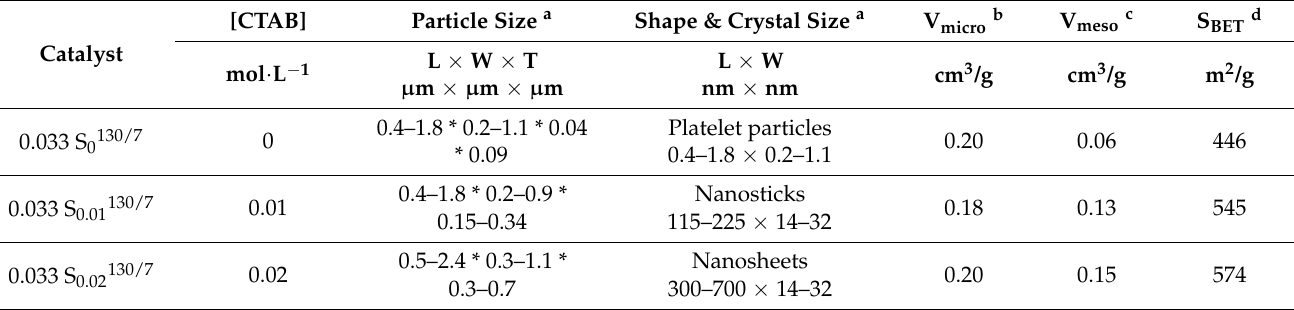
Table 1. Textural properties of the obtained